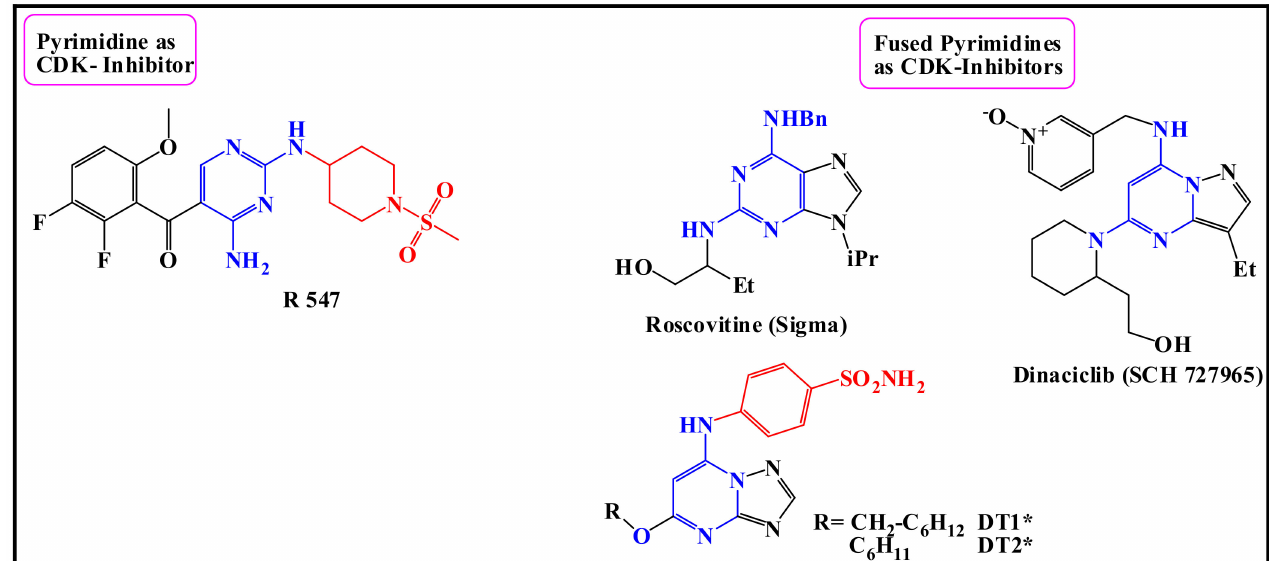
Figure 1. Structures of some CDK inhibitors [21] containing; pyrimidine [22], fused pyrimidine compounds [23–25], and pyrimidine bearing sulfonamide moiety